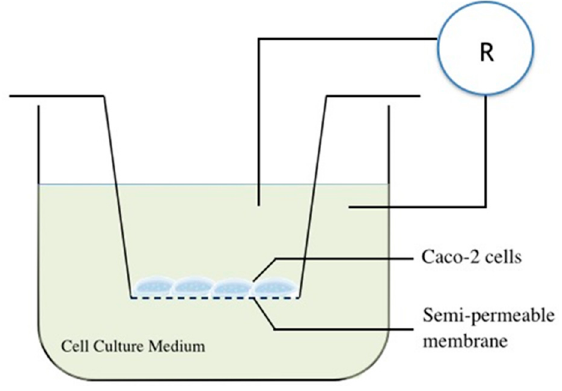
Figure 7. The schematic diagram of the gut epithelial barrier model construction in vitro.